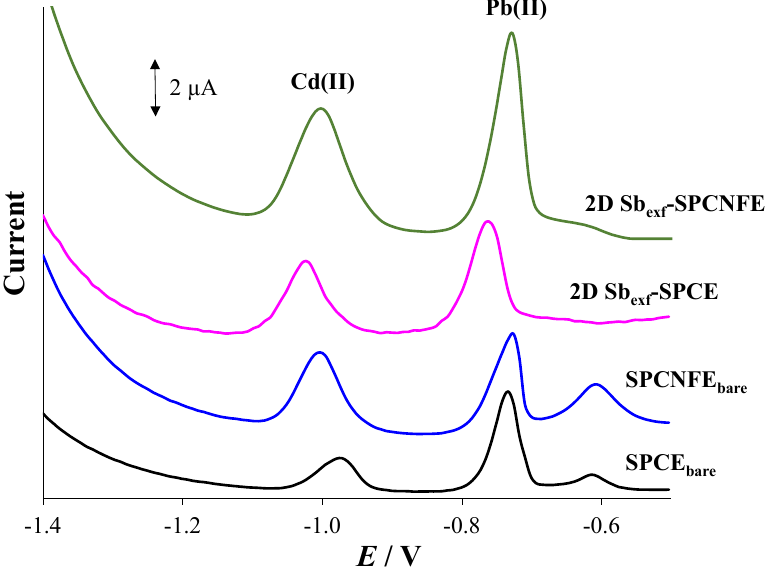
− 1 of Cd(II) and Pb(II) were recorded at pH